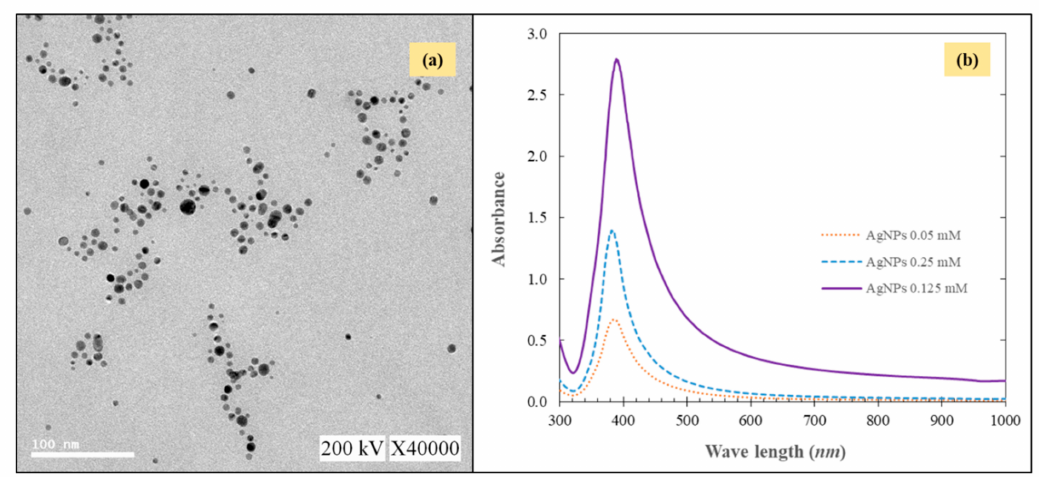
Figure 1. TEM image ( a ) and ( b ) UV-vis absorption spectrum of the